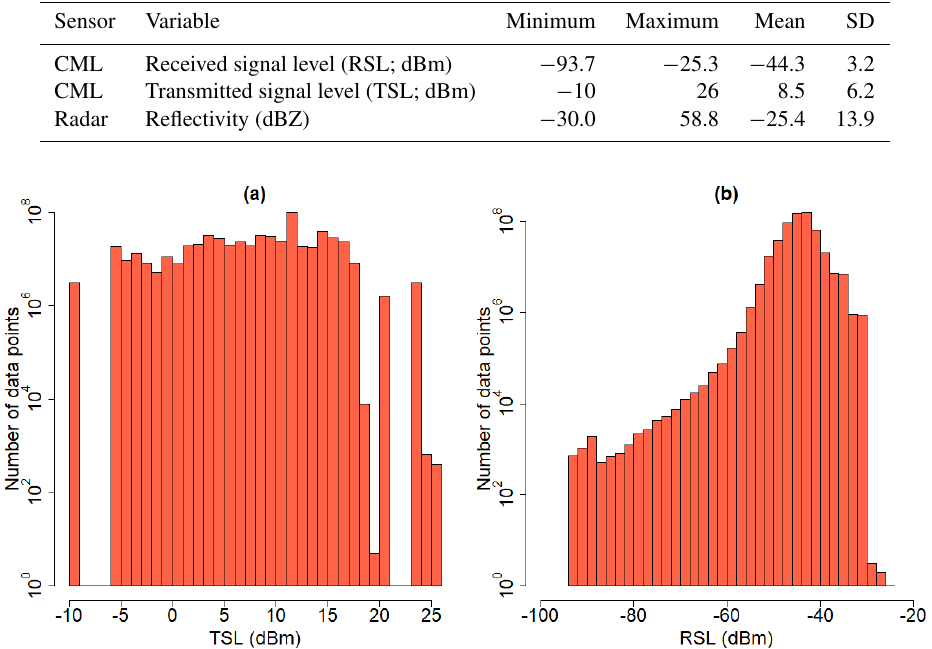
Figure 7. Histograms of (a) transmitted signal level (TSL) and (b) received signal level (RSL). Note that a logarithmic scale is used for the y axis.